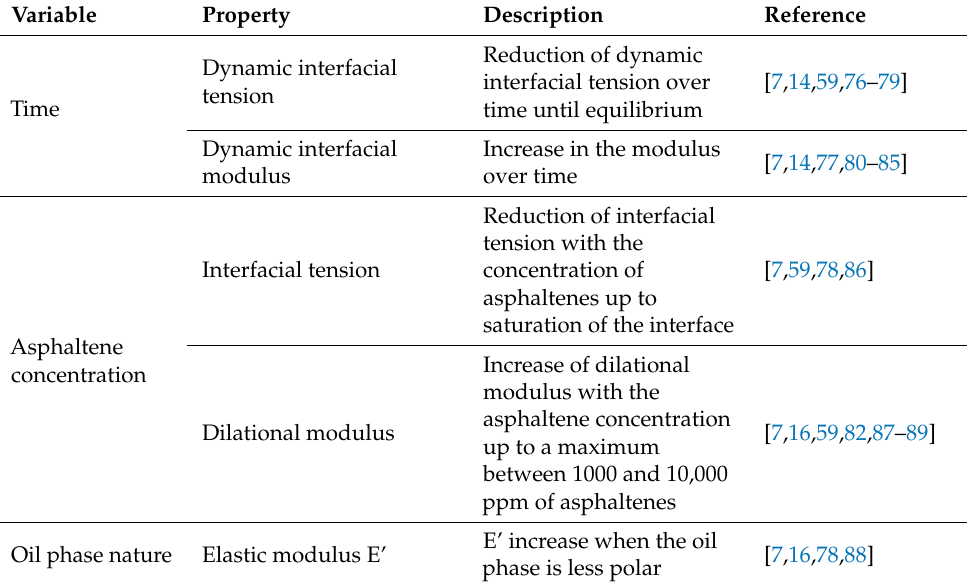
Figure 6. Schematic representation of the aggregation of individual asphaltene molecules in primary asphaltene aggregates. This is followed by formation of larger aggregates, adsorption at the oil-water interface and the formation of a network, generating a rigid viscoelastic film [55,57,58,71]. Table 2. Interfacial rheological properties of water-crude oil